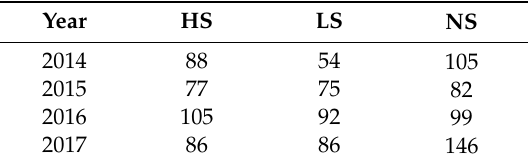
Table 1. E ff ective numbers of high-thunderstorm (HS), low-thunderstorm (LS), and non-thunderstorm (NS) days in each